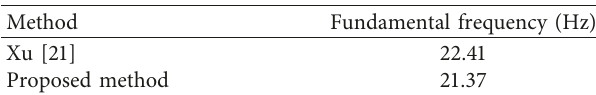
Table 4: Comparison of the fundamental frequency obtained from a full-scale test and the proposed